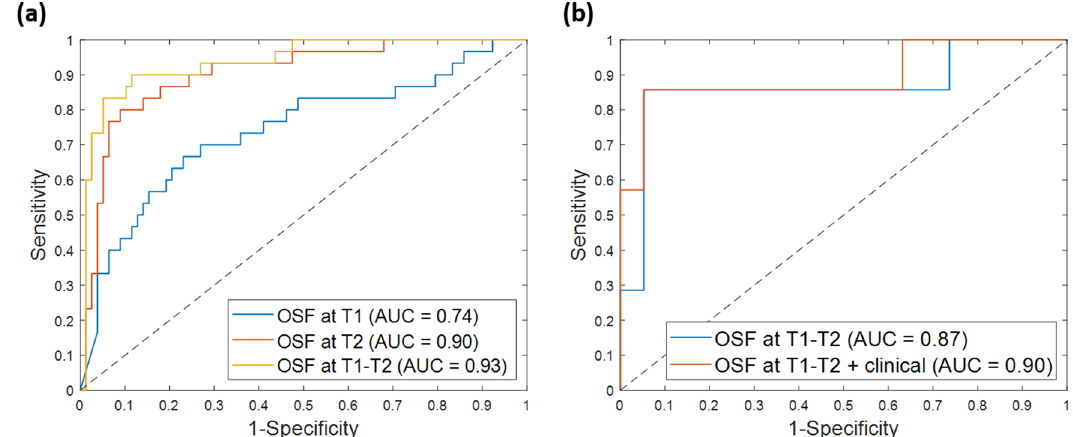
Figure 2. ROC curves for pCR prediction models. ( a ) ROC curves related to the model with the Optimal Subset of Features (OSF) at timepoints T1 and T2 separately or in combination and evaluated on the fine-tuning dataset. ( b ) ROC curves related to the best model (OSF at T1-T2) and the best model with clinical variables (OSF at T1-T2 + clinical) and evaluated on the independent test. ( a , b ) The AUC values are also